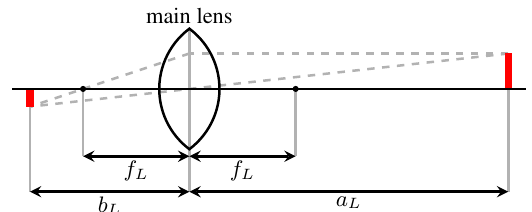
Figure 1. Optical path of a thin lens. An object in the distance a L in front of the main lens results in a focused image in the distance b L behind the main lens.